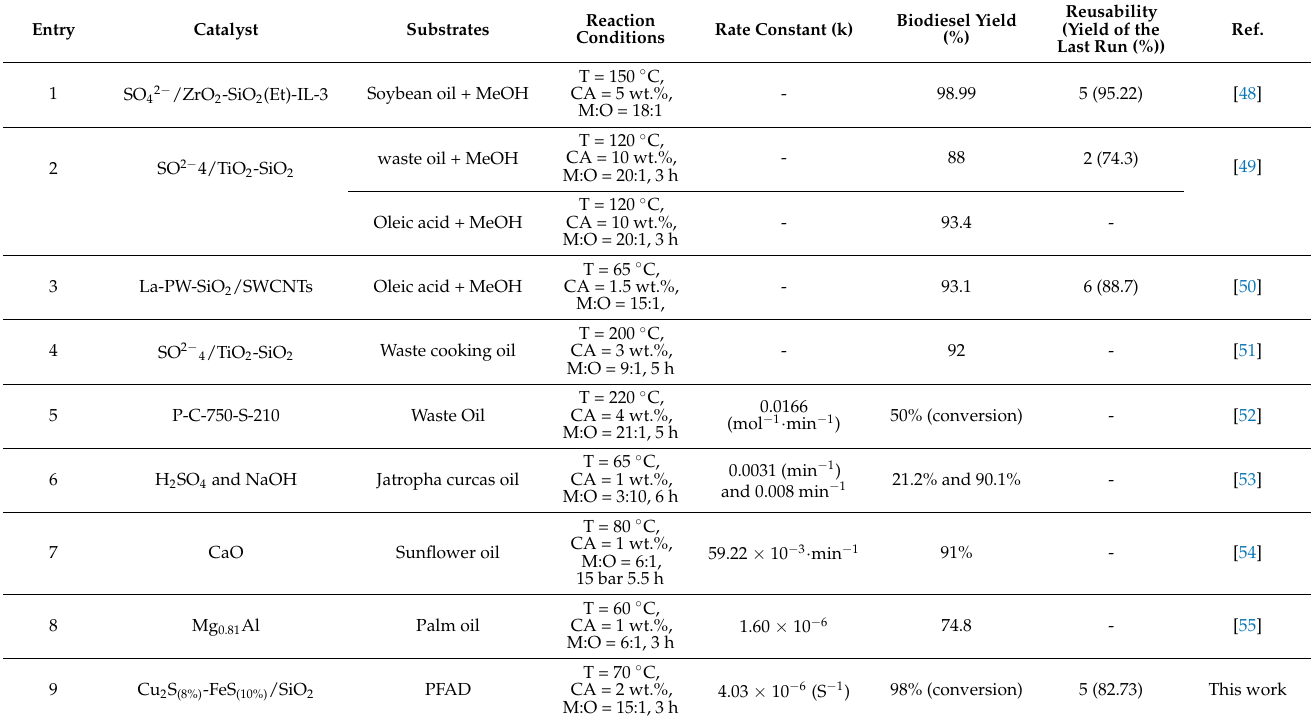
Table 2. Summary of recent studies of catalysts for biodiesel